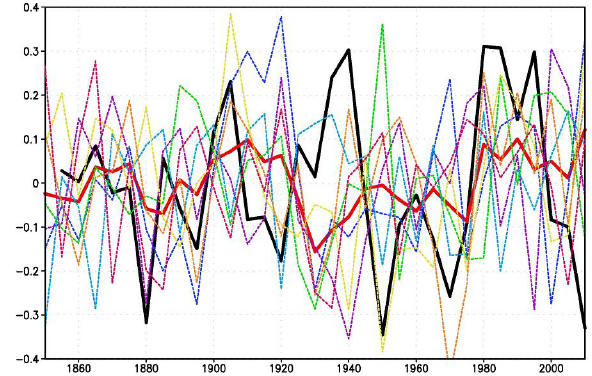
Figure 6. The 5-year mean PDO index (K) for ERSSTv4 data (thick solid black); model mean (thick solid red). Dashed thin lines repre- sent data from individual model runs. Colors correspond to individ- ual runs as in Fig.